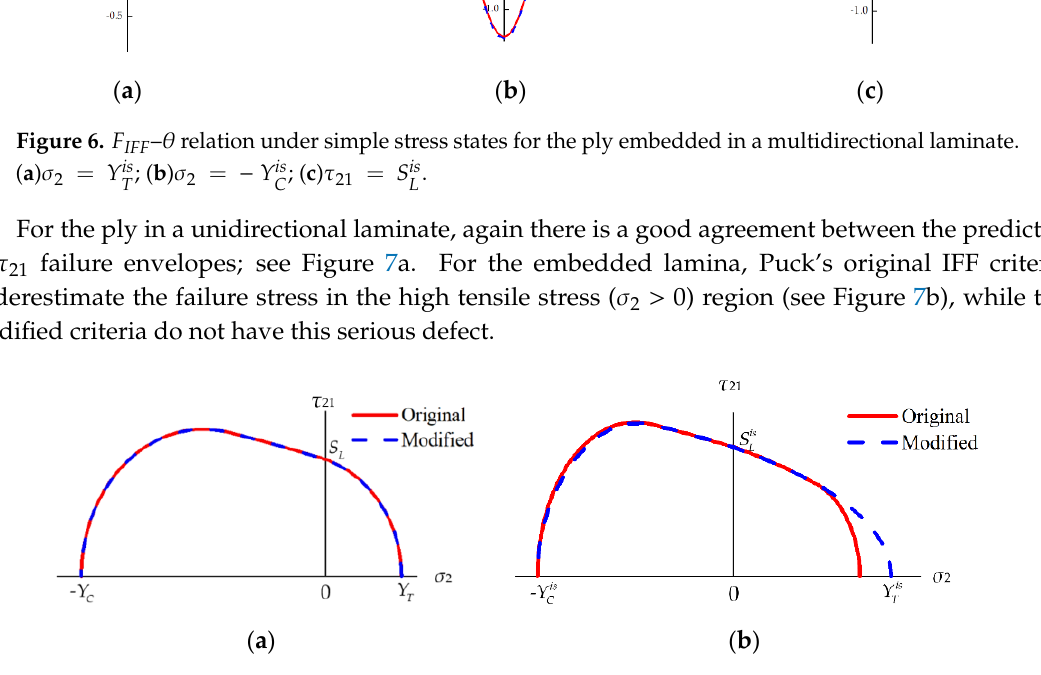
Figure 7. σ 2 - τ 21 failure envelopes. ( a ) Ply in a unidirectional laminate; ( b ) Ply embedded in a multidirectional laminate.